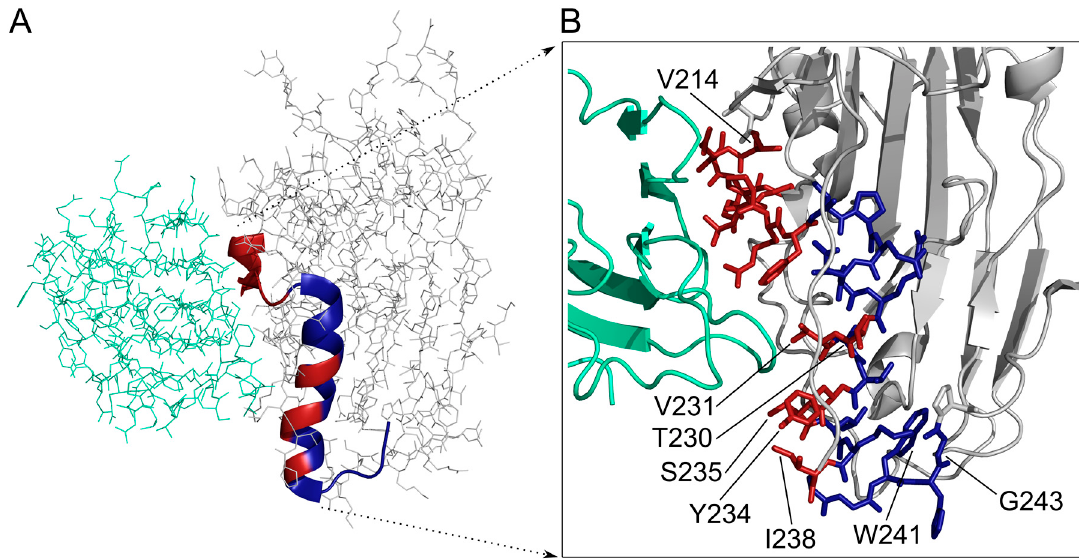
Figure 9. 3D structure of HSV-1 gD glycoprotein (grey) in complex with nectin-1 (ocean green). ( A ) the ribbon indicates the region covered by Set III peptides, red parts participate in the HSV-1 gD – nectin-1 interaction. ( B ) Details of the binding surface with HSV-1 gD 214–243 region are in stick representation, red residues are in contact with nectin-1. After the strongly binding 214–223 segment (red) the non-contacting 224 IPENQR 229 segment can be seen (blue), then 230TVAVYSLKI 238 helical region with alternating contacting and non-contacting residues. Segment 240 GWHG 243 (blue) is folding back on the helical